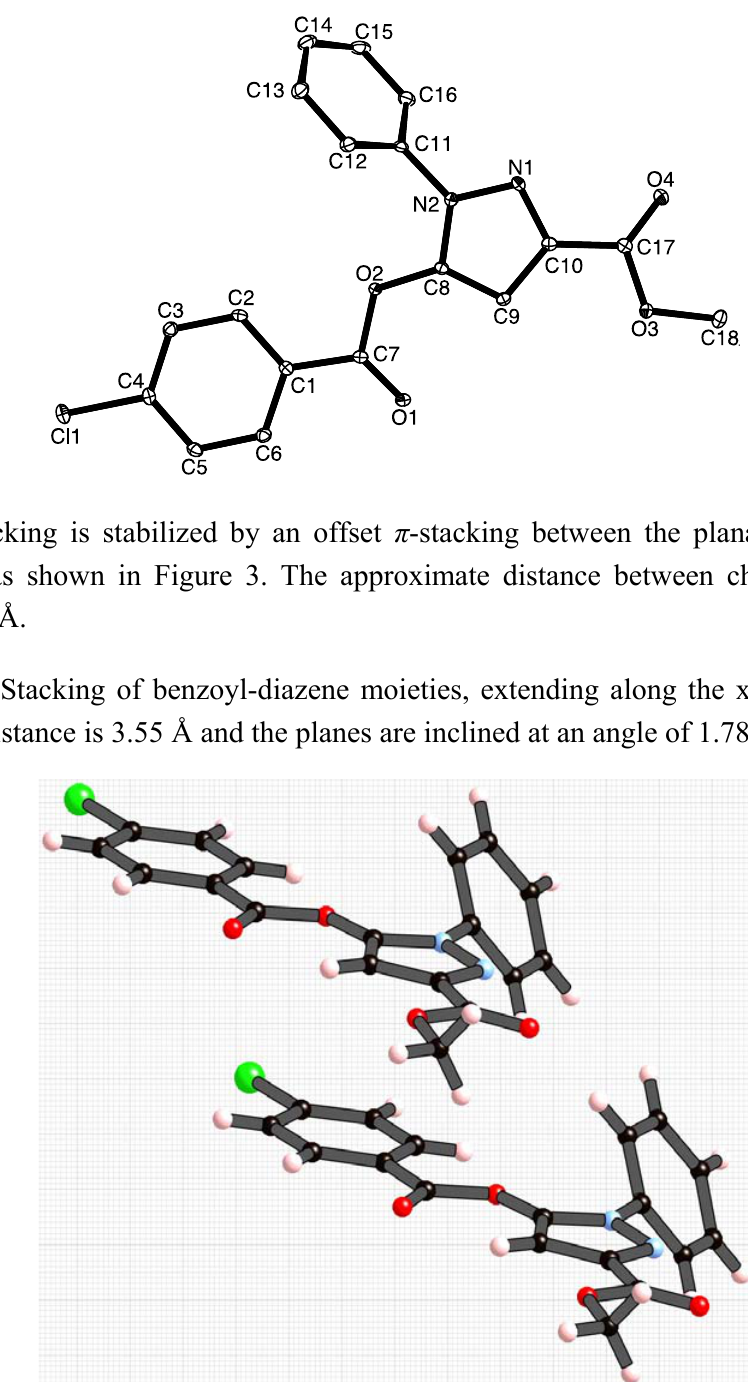
Figure 2. Thermal ellipsoid plot of compound (4), ellipsoids are drawn at the 20% probability level. The H-atoms were omitted in the plot for clarity.